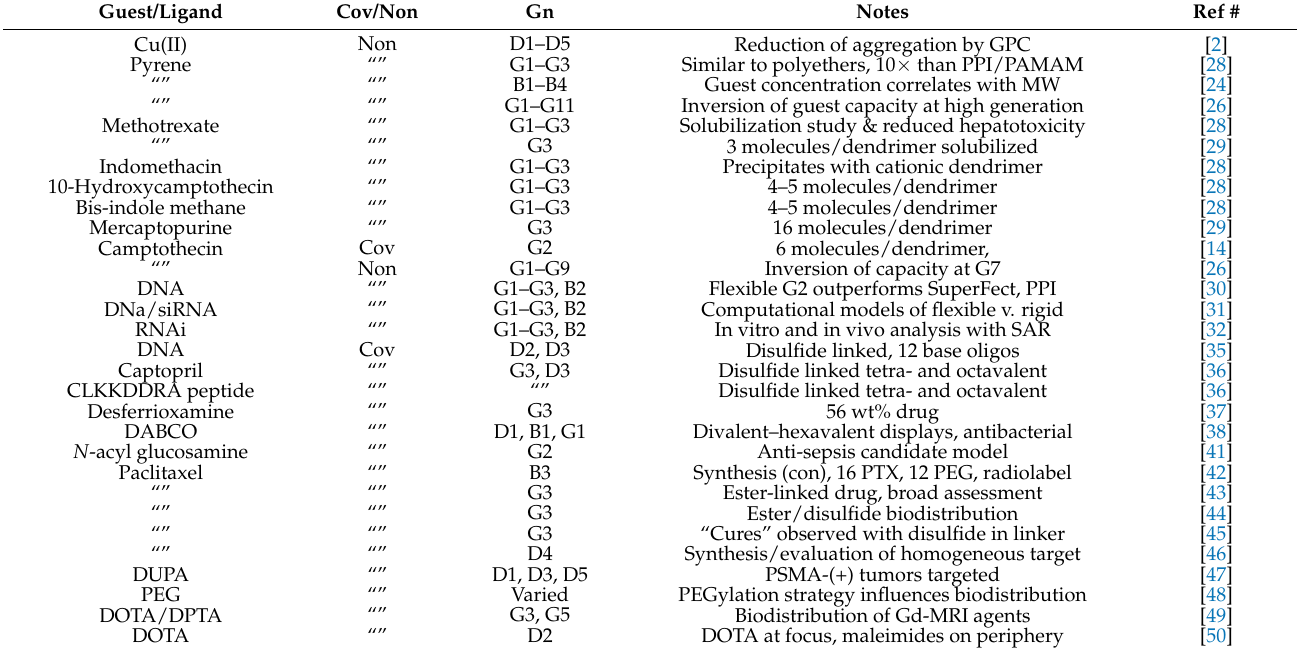
Table 4. Guests and ligands explored.